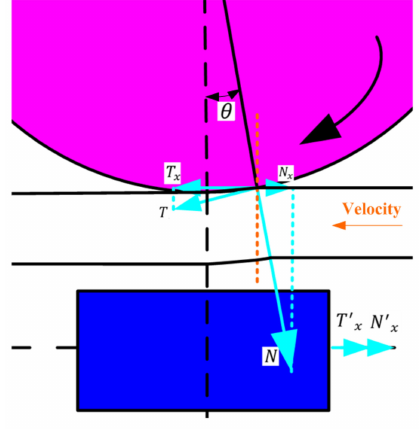
Figure 2. Diagram of the bite condition.